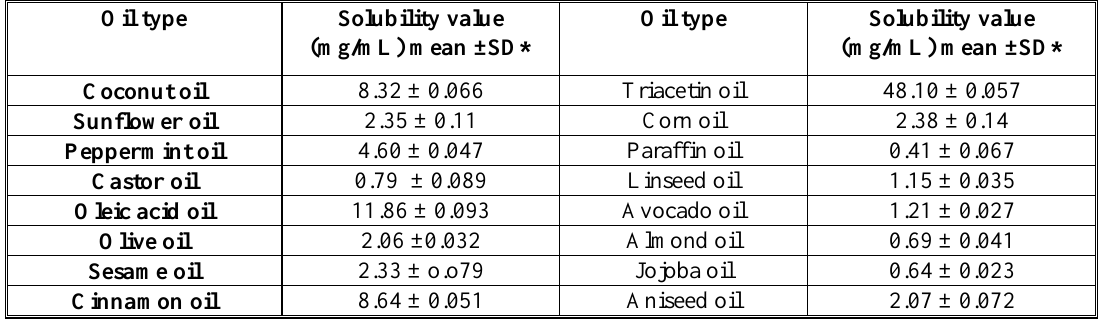
Table 3. Saturation solubility values of piroxicam in different oil types Oil type